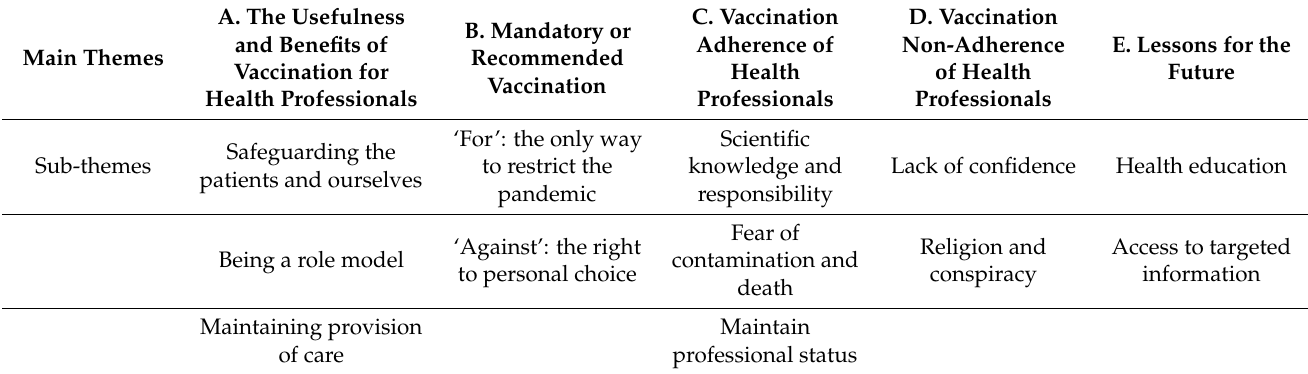
Table 2. Main themes and subthemes derived from data